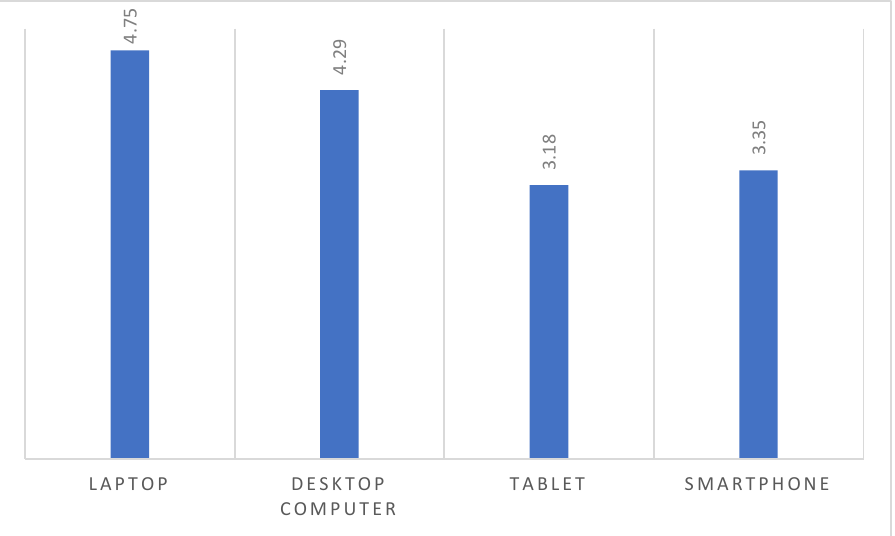
Figure 5. Assessment of the usefulness of the given devices used in e-learning.